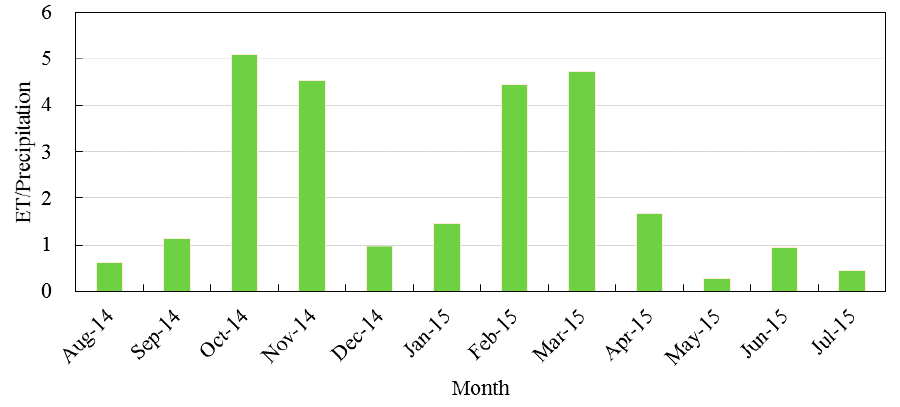
Figure 8. Ratio of ET to precipitation in different months over a one-year period.